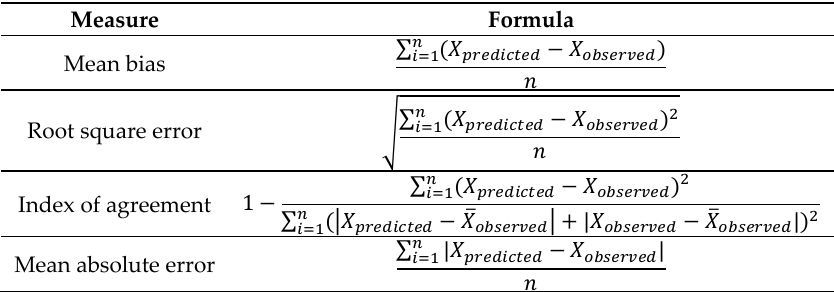
Table 1. Statistical measures representing each